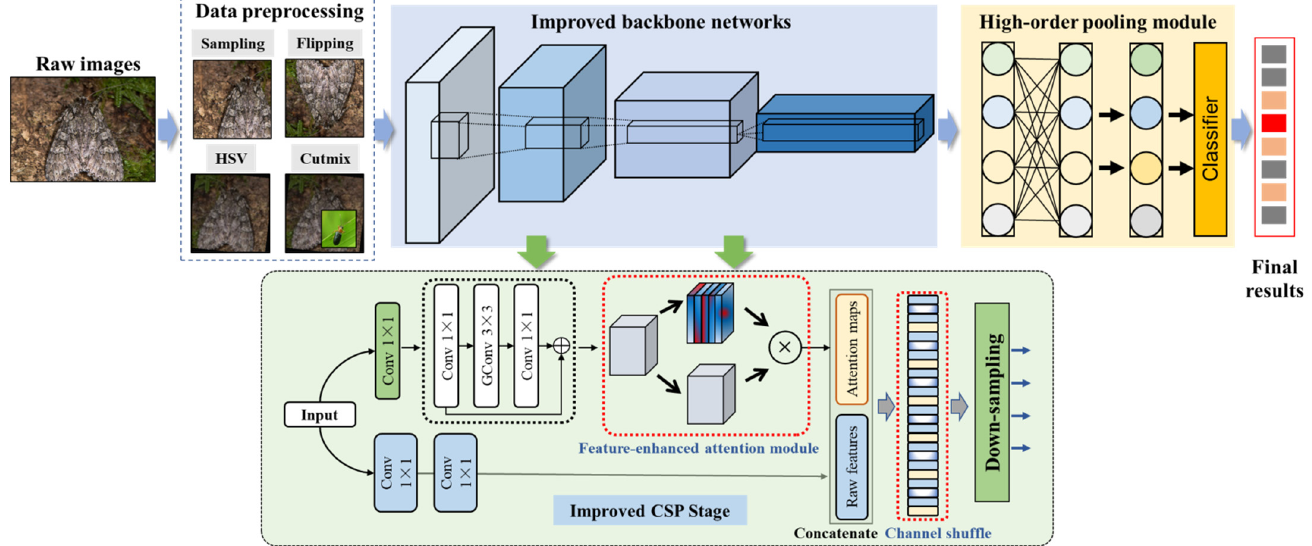
Figure 2. Structure schematic of proposed Fe ‐ Net architecture.